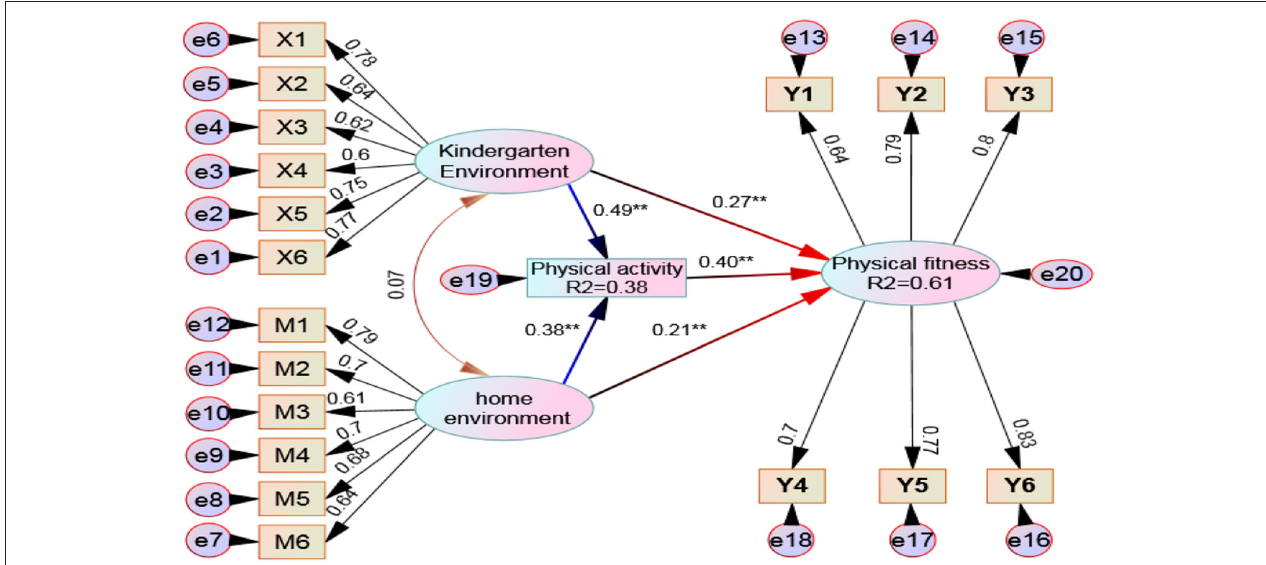
FIGURE 1 | Relationship model between environmental factors, physical activity and children’s health and physical fitness. ** means that the path coefficient has reached a very significant level.